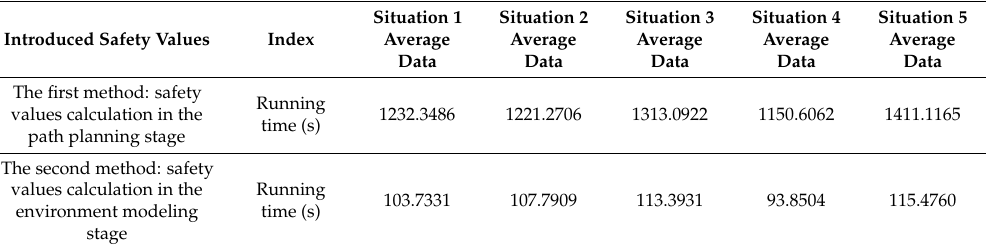
Table 5. Comparison of algorithm running